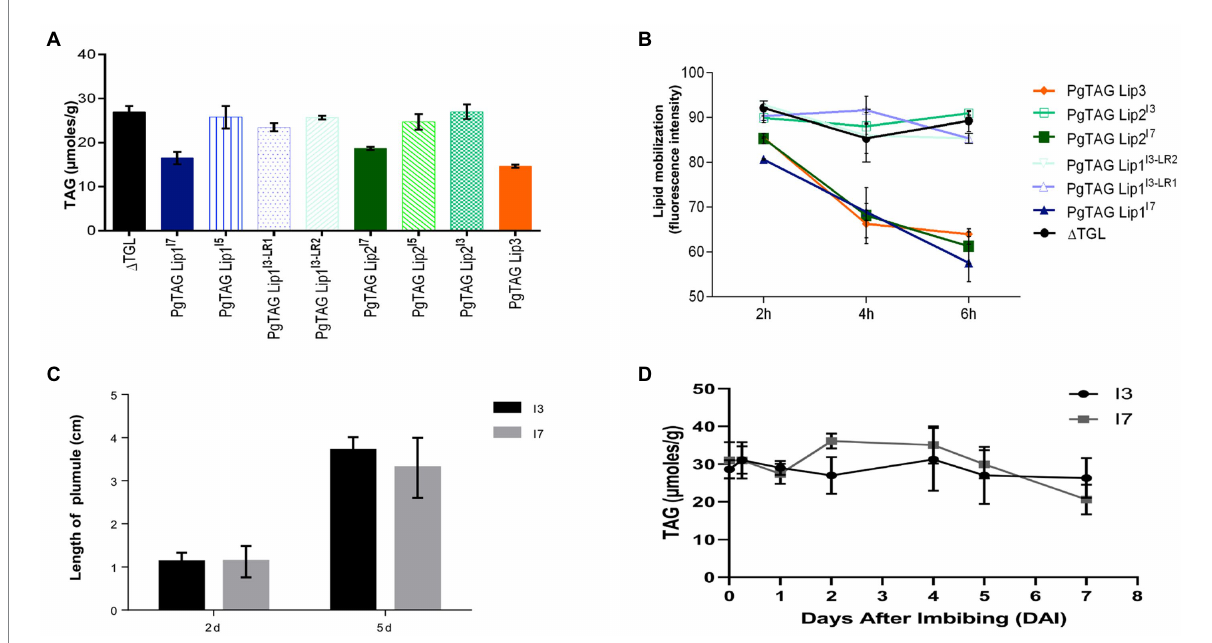
FIGURE 6 Functional validation in yeast expression system and seedling growth of the contrasting pearl millet seeds lines during germination (A) GC-MS TAG analysis of yeast cells expressing TAG lipase variants. Each data point represents the mean of three biological replications with standard error (±SE; B ) in vivo mobilization of TAG reserve in yeast triple lipase mutant expressing TAG lipase variants from 2 h to 6 h. Each data point represents the mean of two biological replications with standard error (±SE). (C) Seedling establishment of I3 and I7 lines. (D) TAG mobilization during germination and post-germinative growth. Each data point represents the mean of three biological replications with standard error